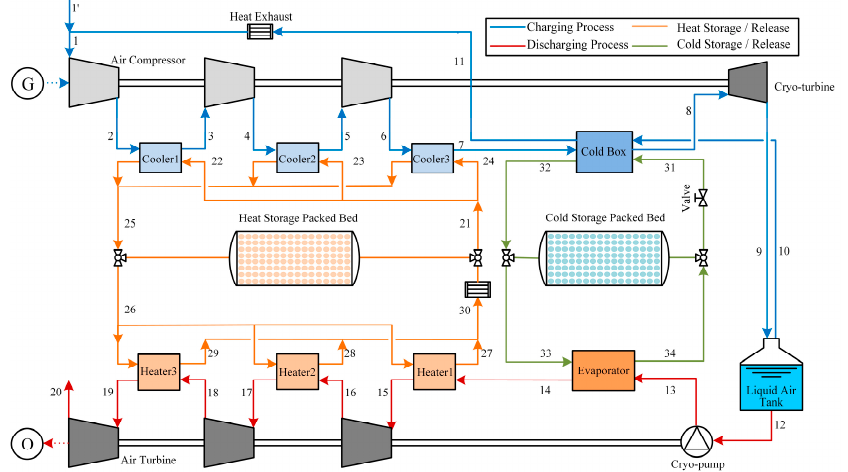
Figure 2. The specific flow figure of the proposed LAES system.